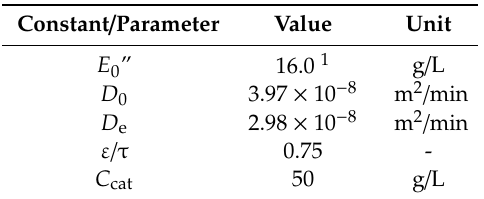
Table 2. β -galactosidase catalyst properties used in the calculation of the conversion curves for the hydrolysis of lactose at 35 ◦